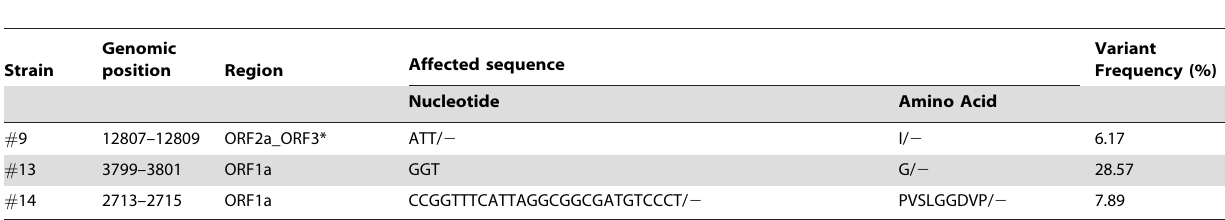
Table 3. Summary features of deletions detected in minor variants of a subset of HK PRRSV